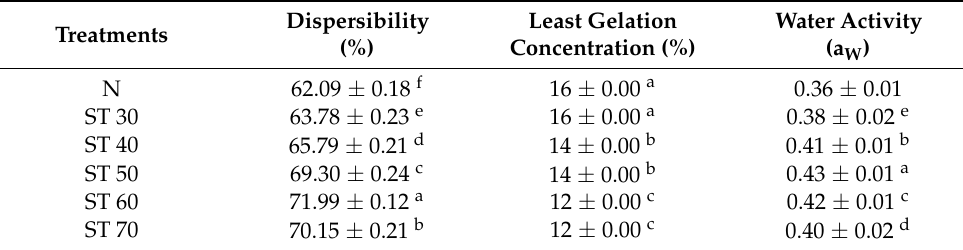
◦ C; ST 60: SC-CO 2 -treated plum kernel protein isolate at